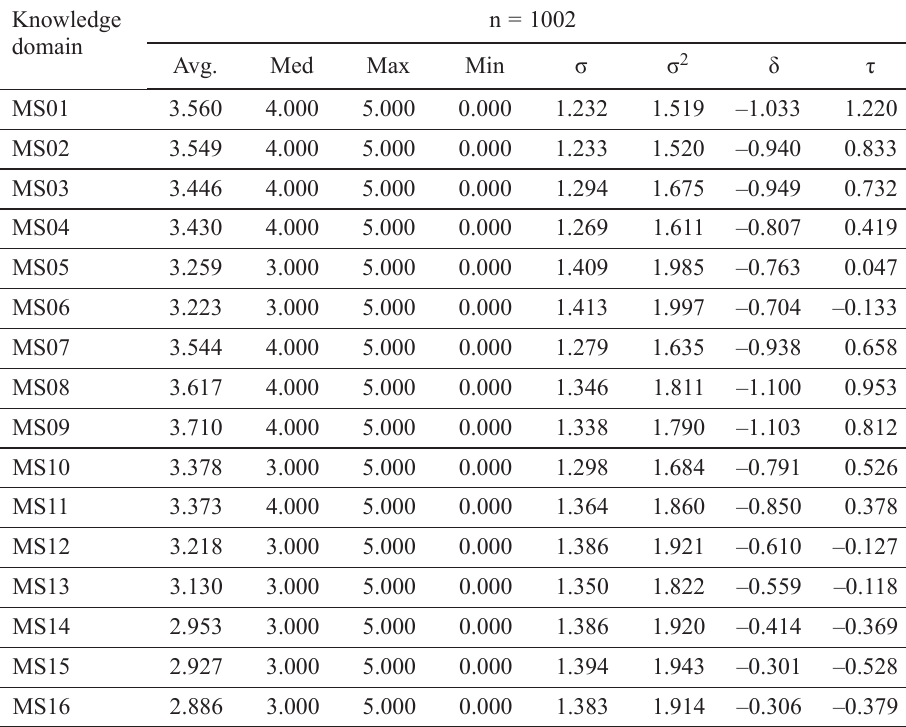
Table 7. Statistical analysis of companies requirements on the role ICT manager, 2006